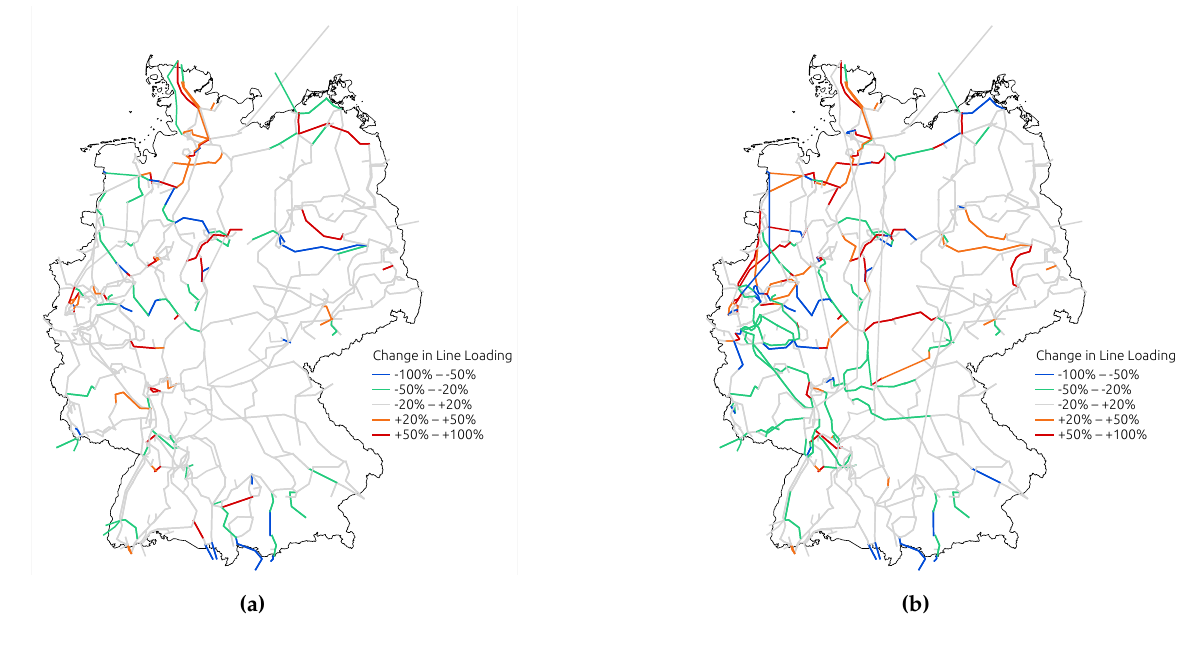
Figure 10. Line loads at 12:00 on 5 December 2020 of contingent disconnection in Germany’s transmission system, with and without the planned HVDC reinforcements. ( a ) Planned HVDC projects incomplete; ( b ) Planned HVDC projects complete.